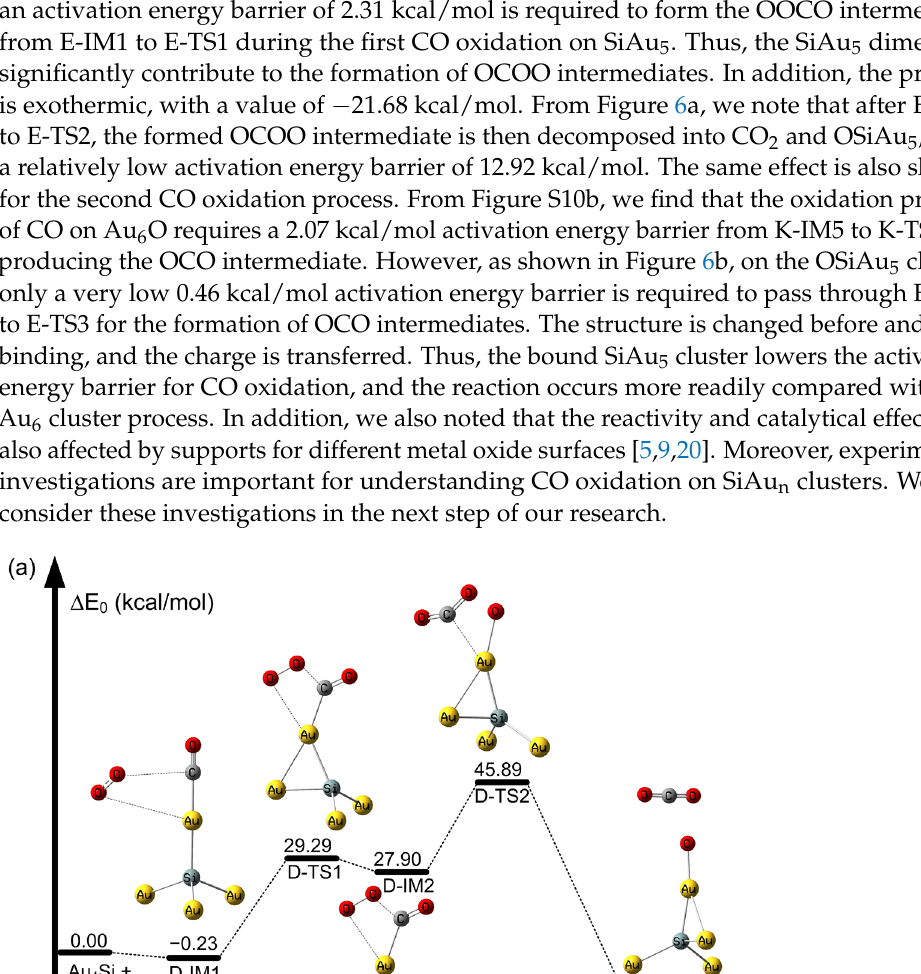
Figure 4. Potential energy profile of CO oxidation on SiAu 3 atoms at the CAM-B3LYP/aug-cc-pVDZ- PP level. ( a ) Oxidation of CO on the SiAu 3 cluster and ( b ) oxidation of CO on the OSiAu 3 cluster (in